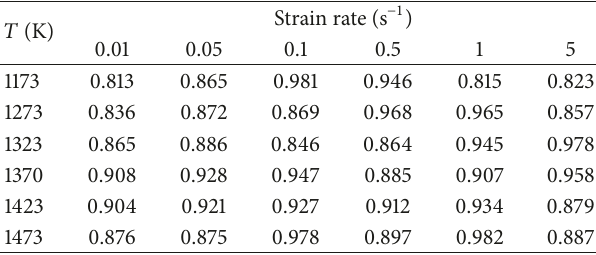
Table 2: The correlation coefficients under different deformation